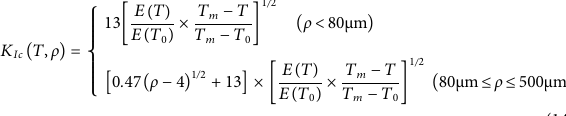
Figure 4 presented the comparison between the experimental (Srinivas and Kamat, 2000) and theoretical predictions of aluminum alloy. In the calculation, Young ’ s modulus of aluminum alloy was obtained by the existing yield strength in the literature (Srinivas and Kamat, 2000), and the temperature- dependent yield strength model is established by Zhang et al. (2017a) due to lack of its values at elevated temperatures. Also T m =660 ° C (Zedalis et al., 1989), T 0 =25 ° C, and d =2 μ m. Figure 4 shows that our temperature- and notch root radius-dependent fracture toughness model (Eq. 13) can well-predict the K Ic of aluminum alloy at different notch root radius from room temperature to 350 ° C. The evolution of notch root radius ’ s in fl uence on K Ic was neglected, which led to a small difference between the predicted and experimental data above room temperature when ρ equals 500 μ m.